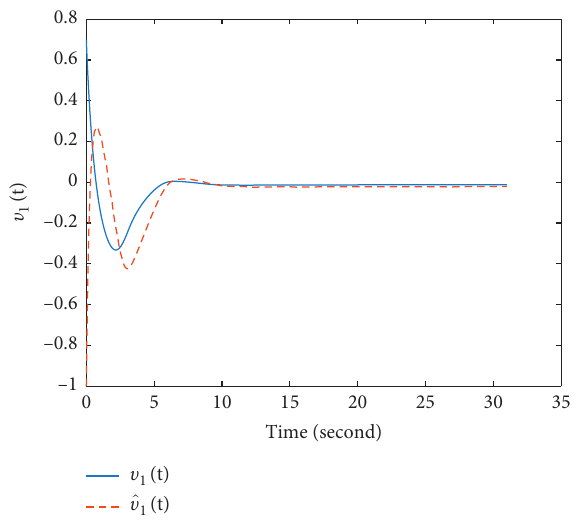
Figure 6: Trajectories of υ